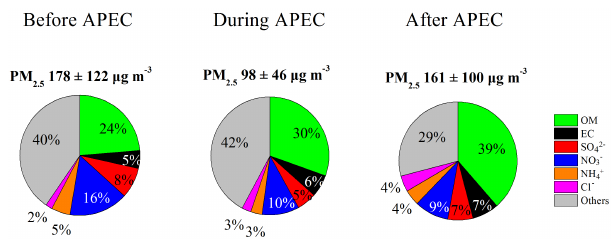
Figure 2. Chemical composition of PM 2 . 5 during the 2014 APEC campaign.